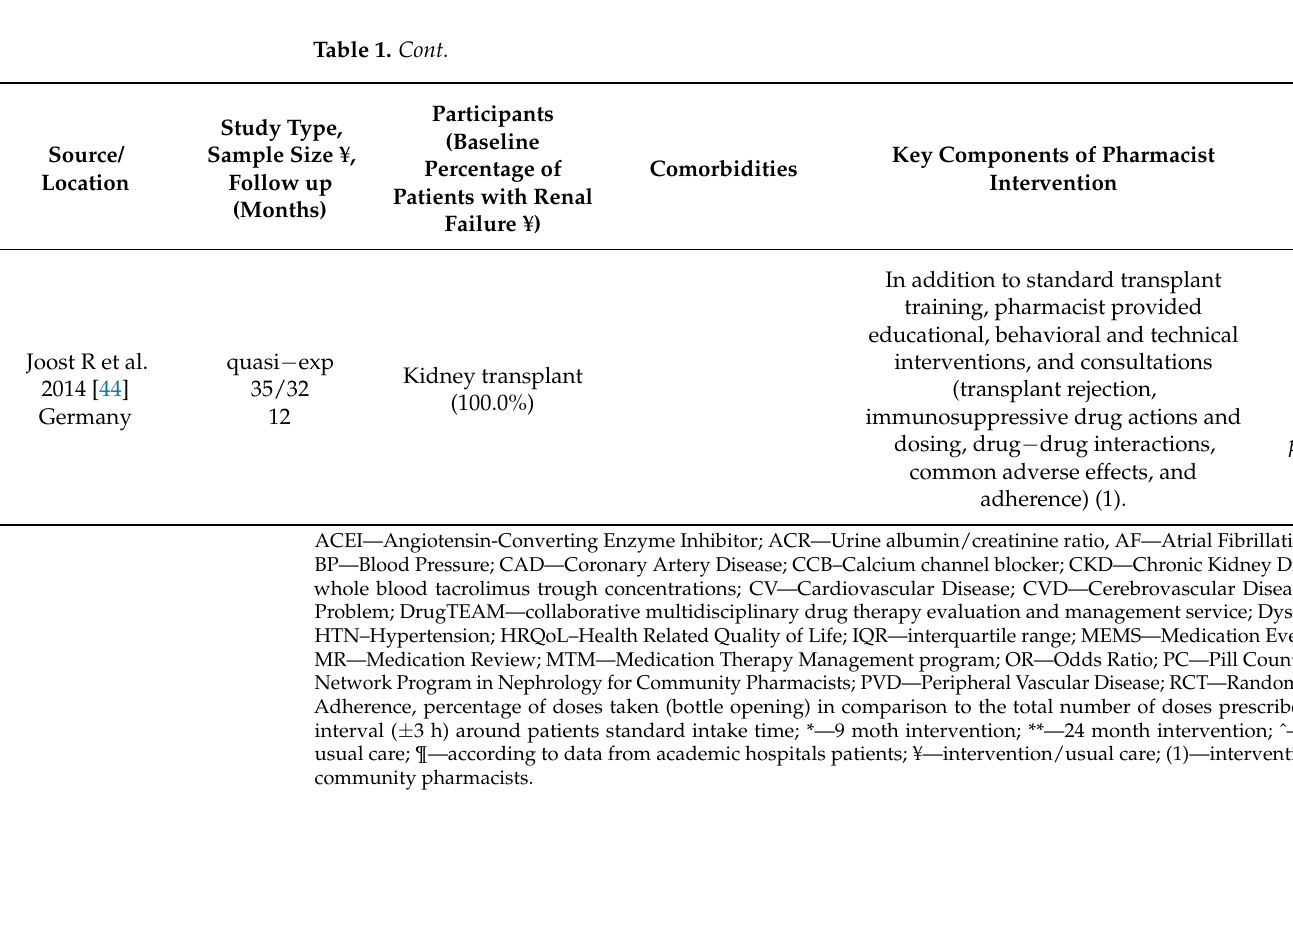
Key Components of Pharmacist Intervention